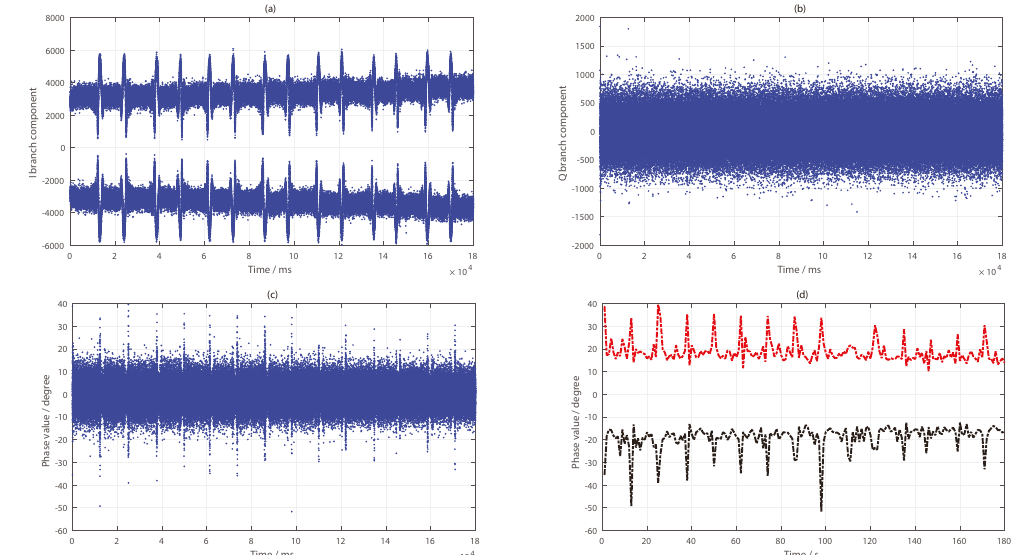
Figure 21. Results of the BeiDou PRN27 satellite reflected signal: ( a ) I branch component data; ( b ) Q branch component data; ( c ) phase difference information (in ms); ( d ). phase difference information (in s).